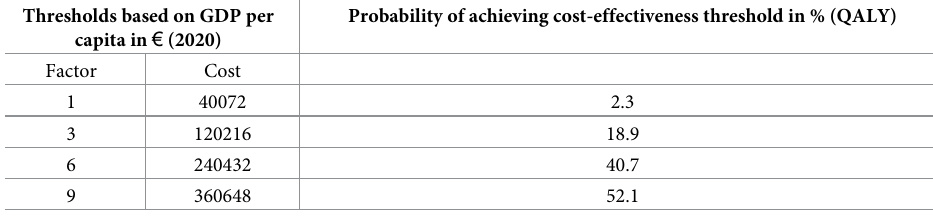
Table 4. Probability of achieving cost-effectiveness at estimated willingness-to-pay